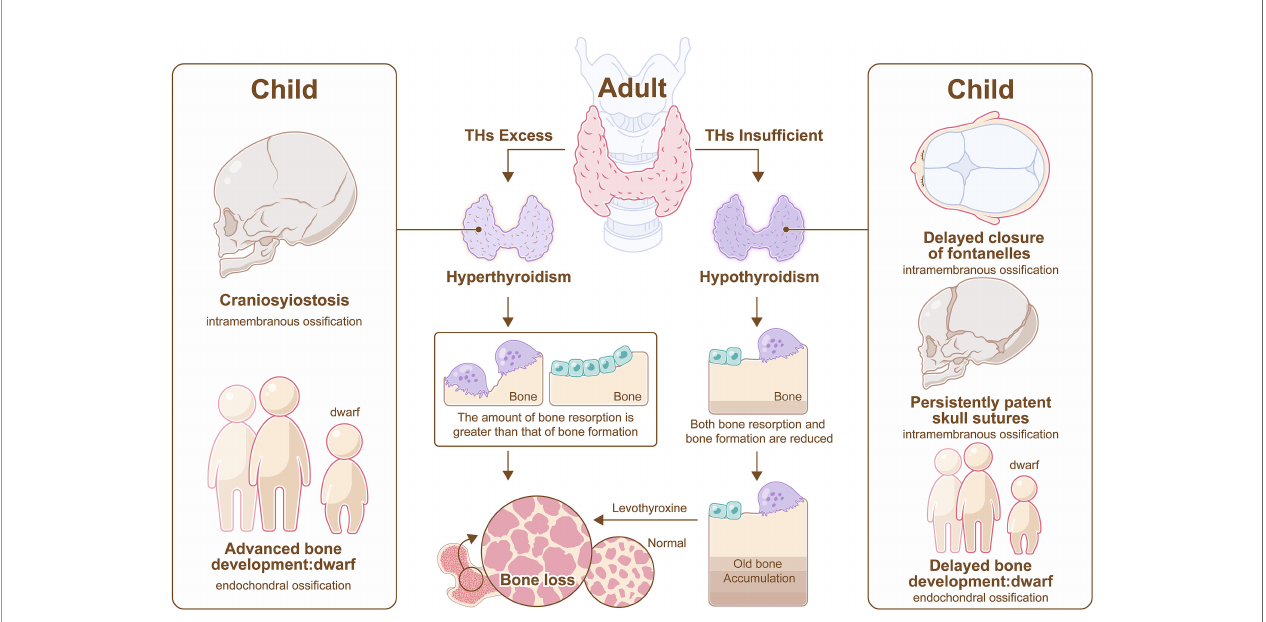
FIGURE 4 | Hyperthyroidism and hypothyroidism on bone. In adult, hyperthyroidism promotes more bone resorption than bone formation, resulting in bone loss, and hypothyroidism impedes bone remodeling, resulting in old bone accumulation, however, bone loss also appears in hypothyroidism after the administration of LT4. In child, hypothyroidism impairs both endochondral and intramembranous ossi fi cation, which manifest as delayed closure of fontanelles, persistently patent skull sutures, and short stature, and hyperthyroidism results in craniosynostosis and below-average